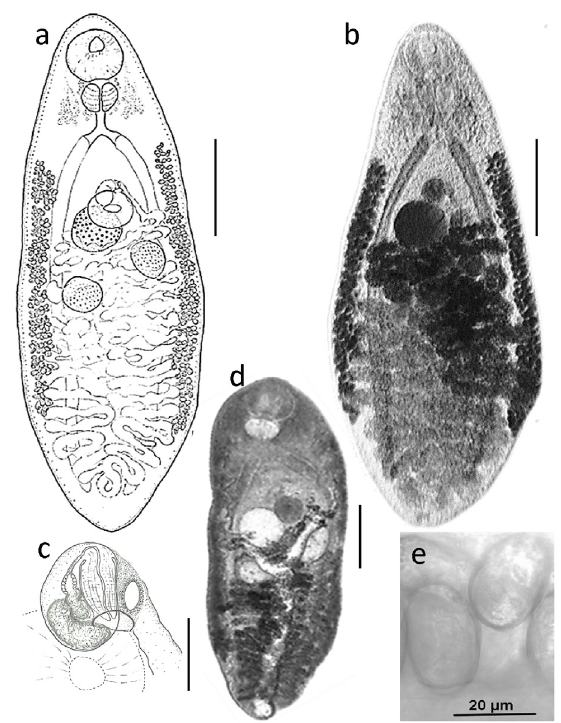
Figure 1. Choledocystus incurvatum ( a, b ) body in ventral view, ( c ) detail of terminal genitalia, ( d ) body in ventral view showing excretory vesicle, ( e ) detail of eggs in the uterus. Scale bars: a, b, d = 500µm; c = 100